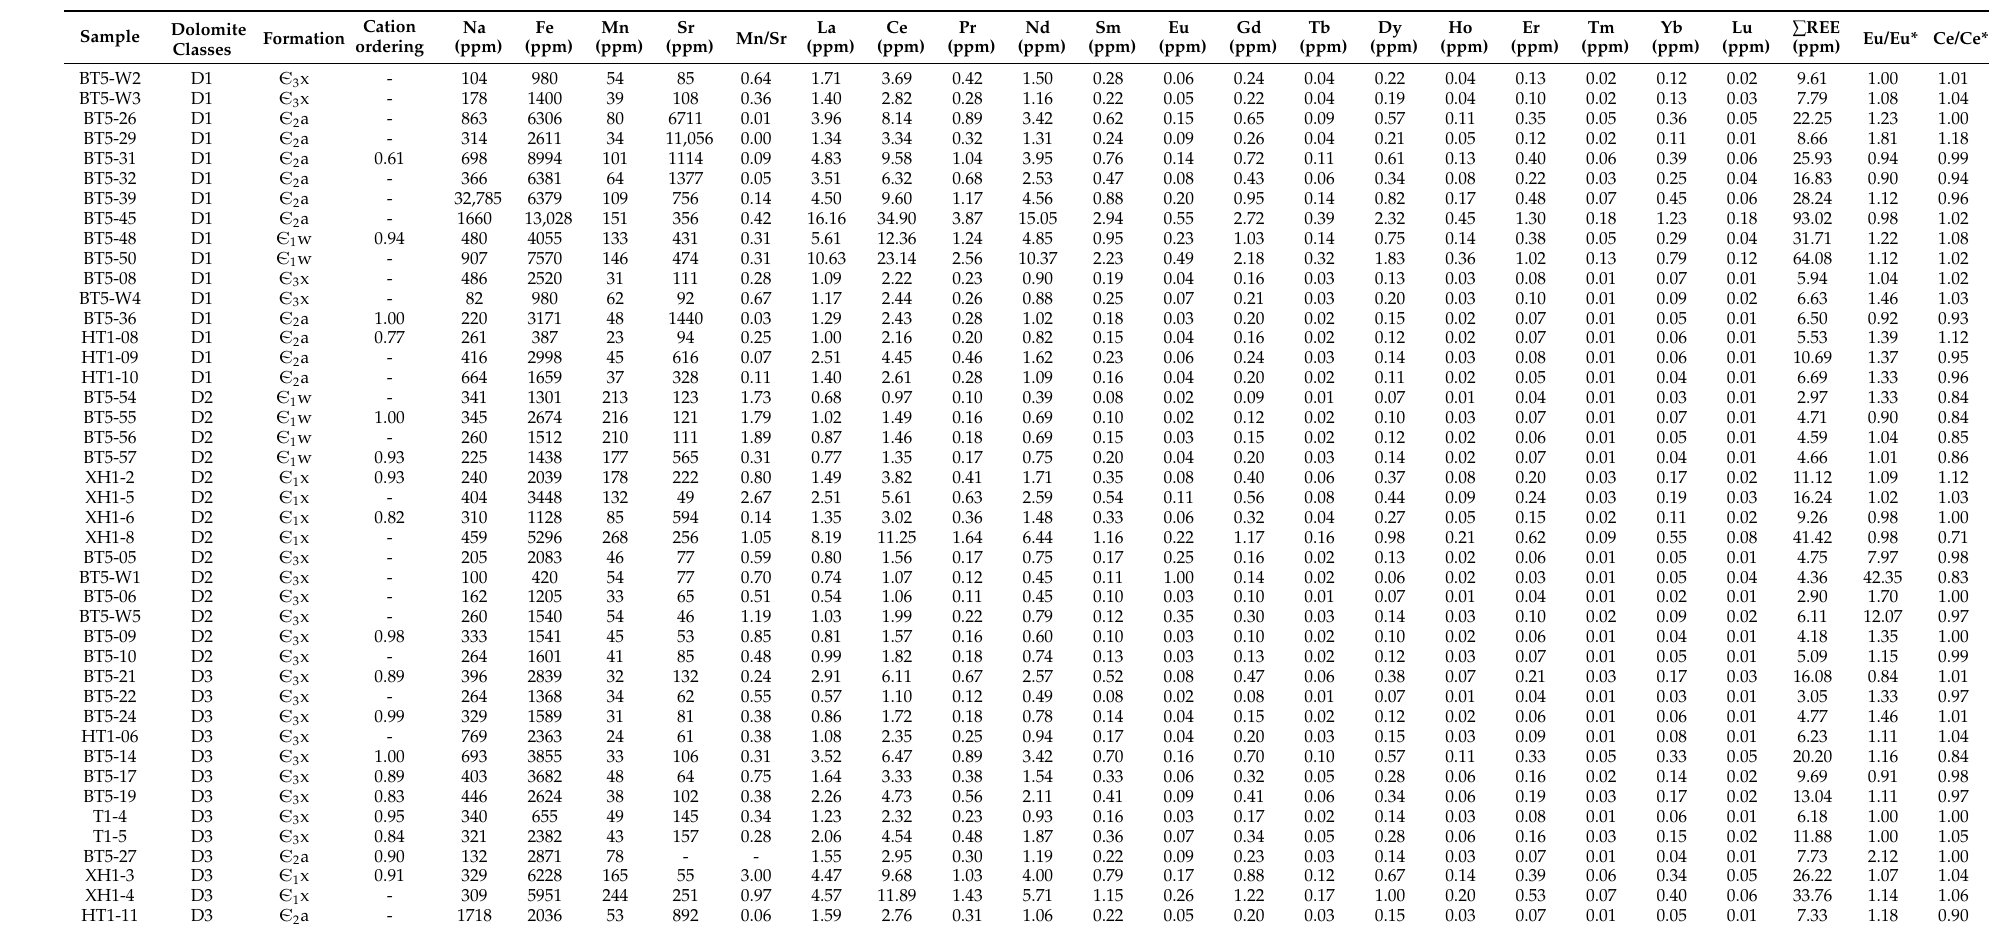
Table 1. Summary statistics of major elements, trace elements, and rare earth elements of the Cambrian dolomites in the Bachu area, Tarim